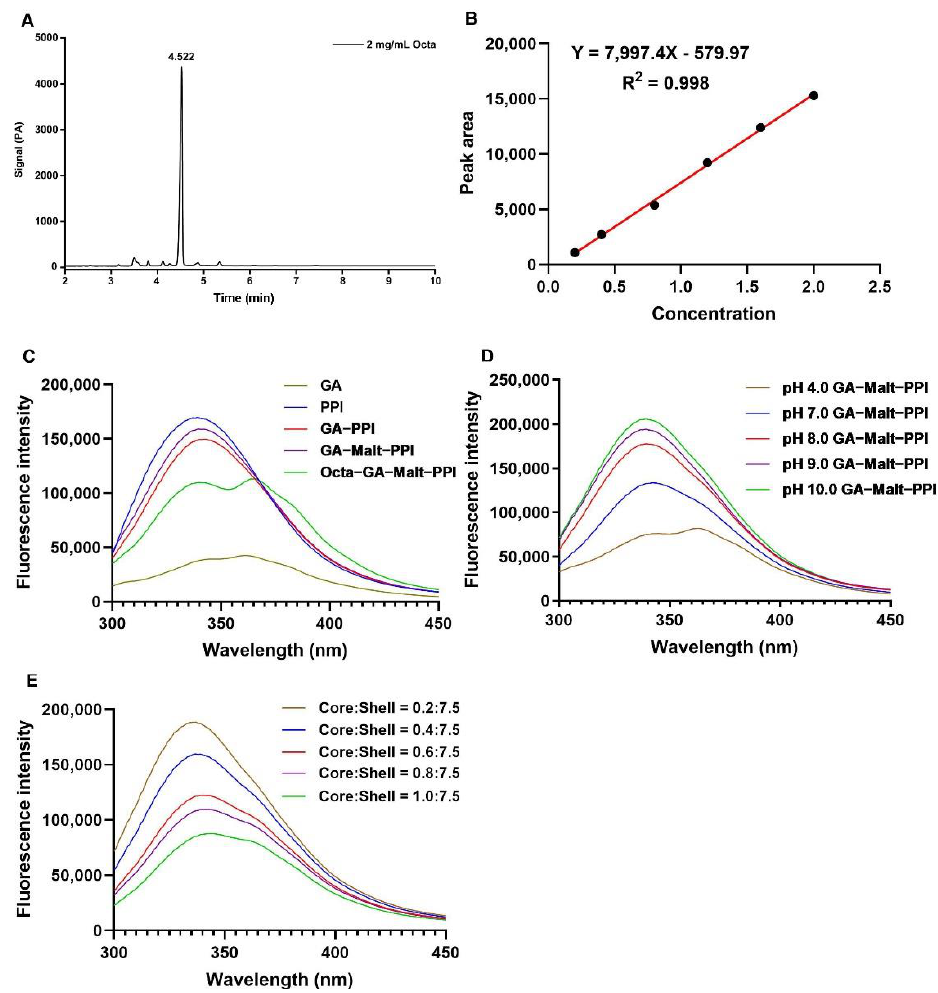
Figure 1. ( A ) Peak time for Octa in GC analysis. ( B ) Calibration curve of Octa in GC analysis. ( CE ) Fluorescence emission spectra of samples. ( C ) GA, PPI, GA − PPI, GA − Malt − PPI, and Octa − GA − Malt − PPI. ( D ) GA − Malt − PPI at different pH. ( E ) Octa − GA − Malt − PPI at different core:shell ratios.